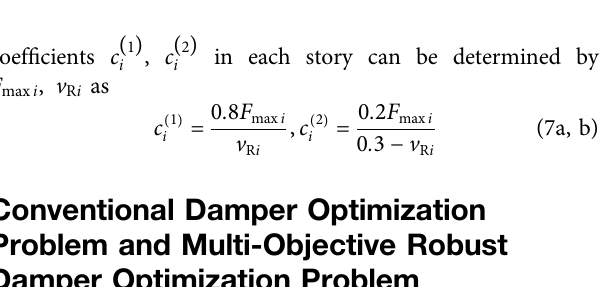
FIGURE 8 | Optimal damper characteristics for ordinary problem without uncertainties (Damping coef fi cient for linear oil damper, Maximum allowable damping force and relief velocity for bi-linear oil damper).